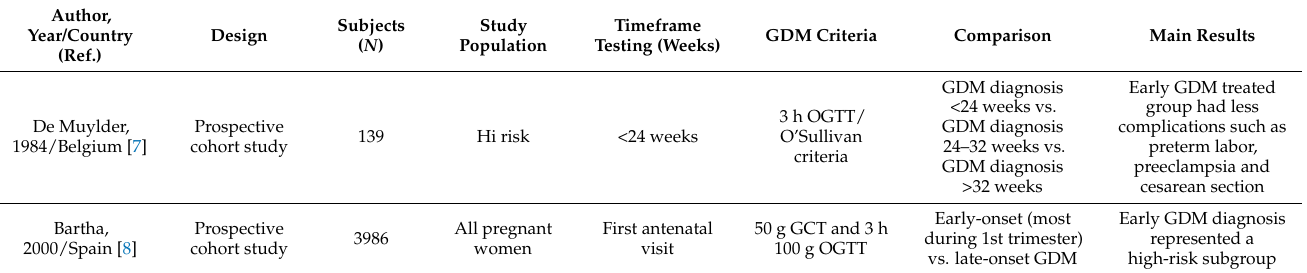
Table 1. Observational